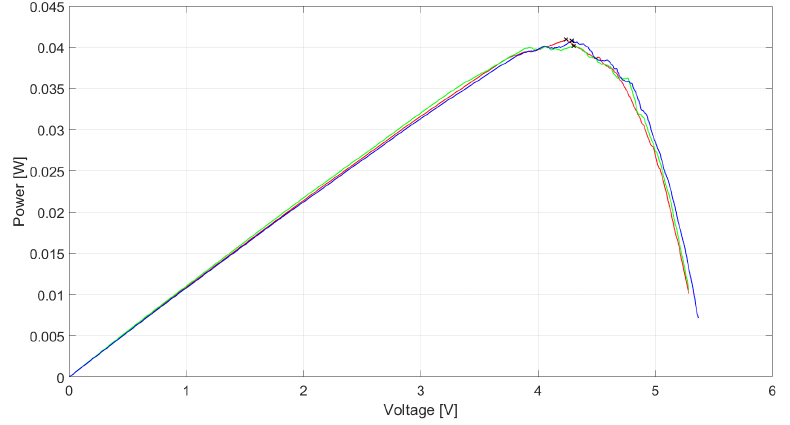
Figure 15. Voltage–power characteristics from 3 measurements of the solar panel. Black X-marks indicate the VMPP for each curve.